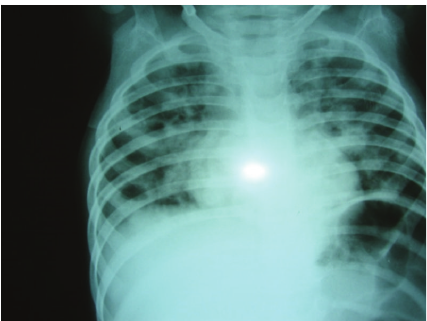
Figure 1: Chest radiograph revealed diffuse infiltration in right lung with thick walled cavities in mid and lower zone. Infiltrations were also seen in left upper parahilar region.